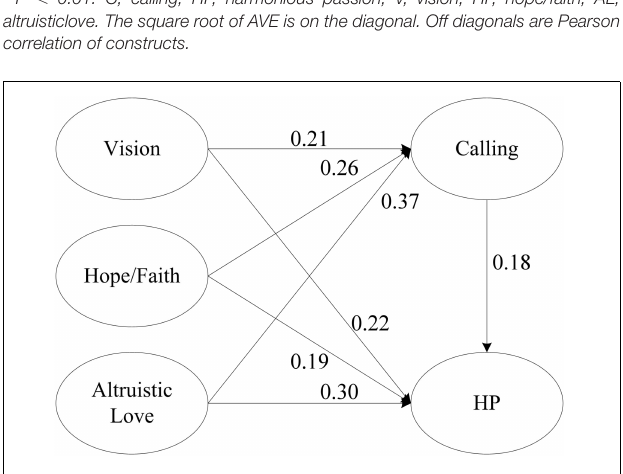
FIGURE 2 | Final structural model with different path results.